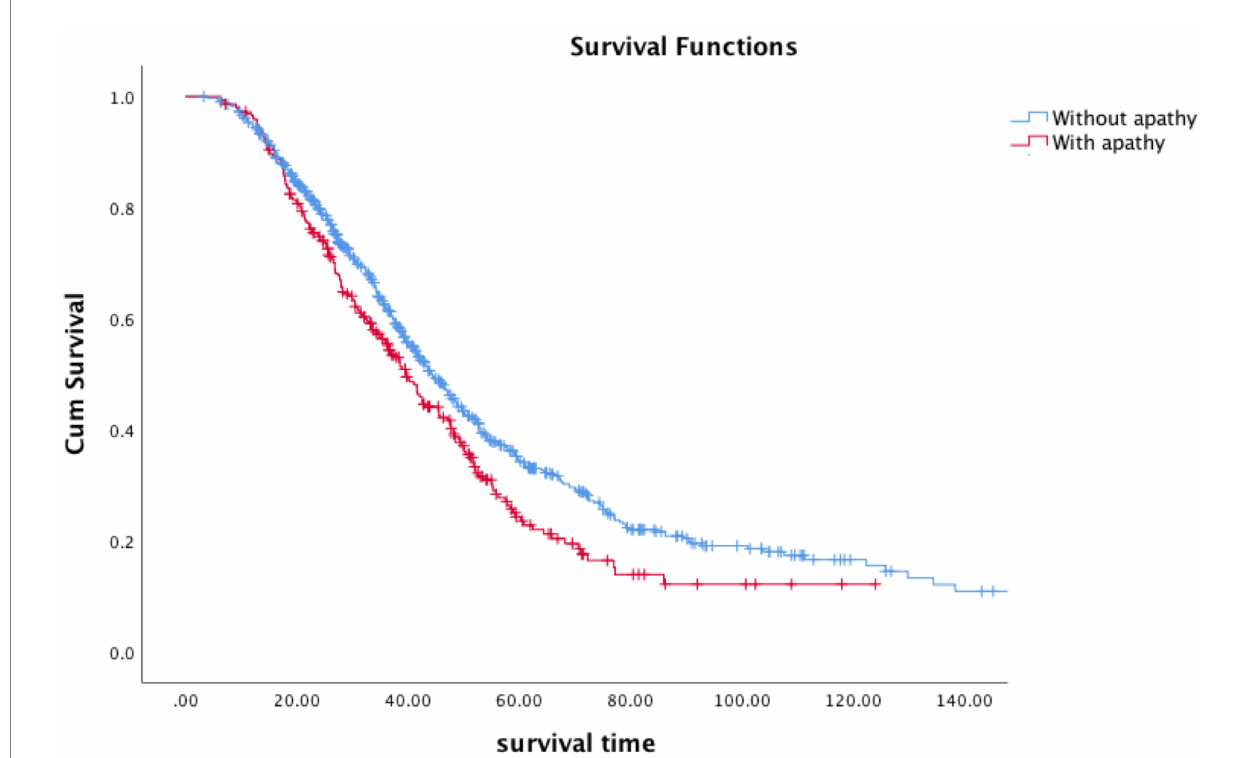
FIGURE 1 Survival curves according to apathy in ALS patients (blue, without apathy; red, with